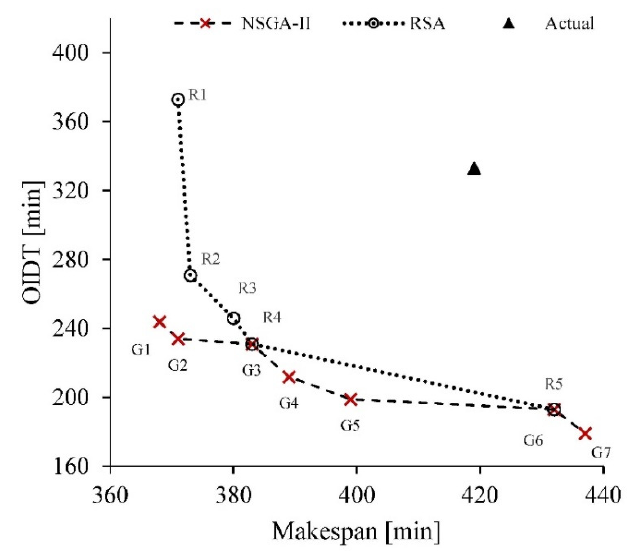
Figure 12. The solutions for BMP-I obtained by NSGA-II and RSA.